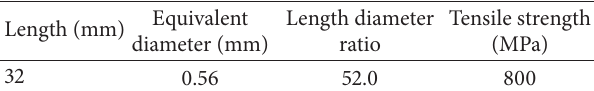
Figure 1: Photograph of the steel fibers used.